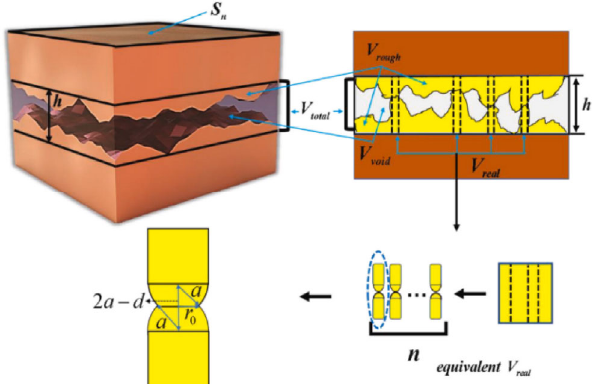
Fig. 73 Schematic diagram of the contact volumes and the equivalent real contact volume between rough surfaces [912]. Reproduced with permission from Ref. [912], © Elsevier Ltd., 2021.